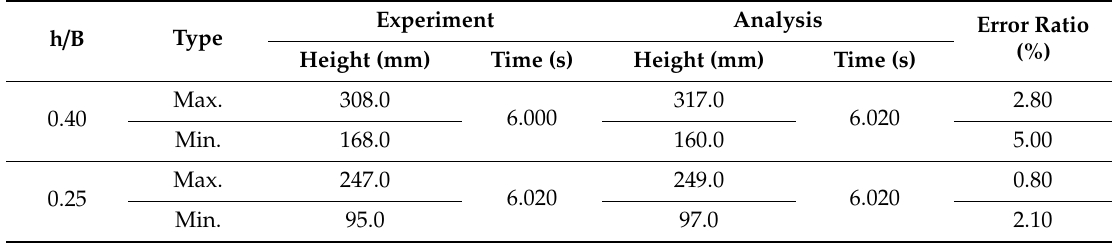
Figure 5. Comparison of sloshing height from experiment and analysis. Table 3. Comparison of sloshing height between experiment and analysis.